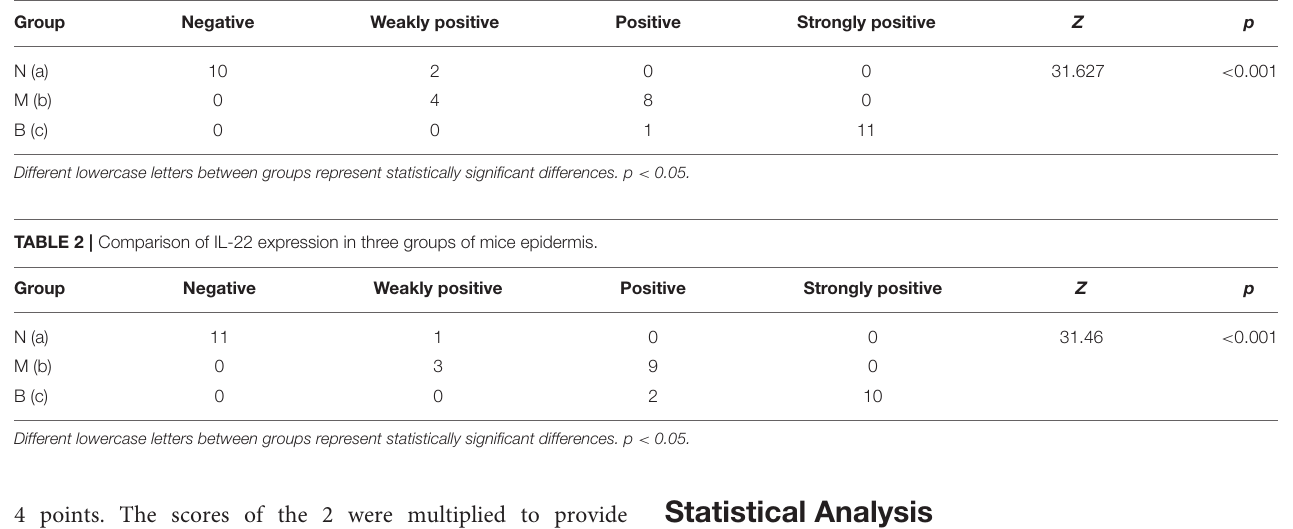
TABLE 1 | Comparison of IL-17 expression in three groups of mice epidermis. Group Negative Weakly positive Positive Strongly positive Z p 10 2 0 0 31.627 < 0.001 4 8 0